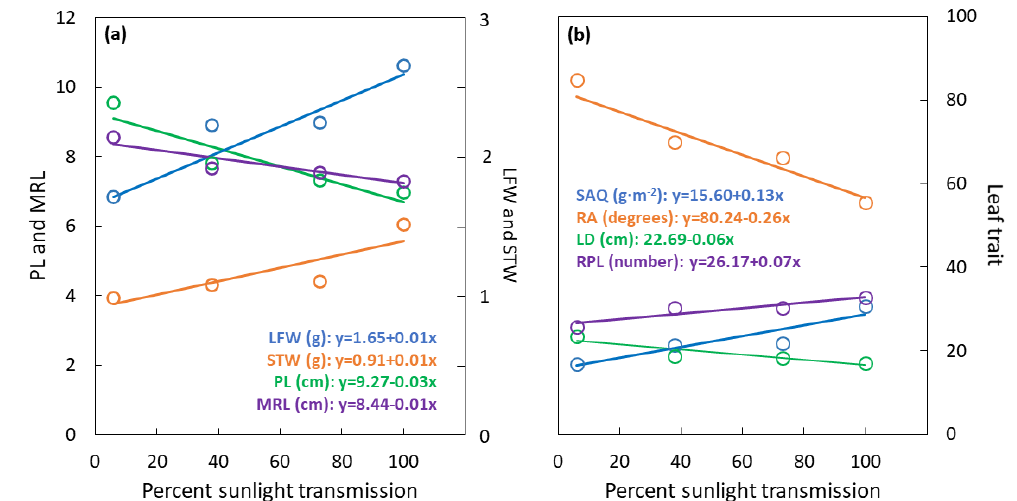
Figure 3. Serianthes nelsonii leaf traits as influenced by percent sunlight transmission during leaf development. ( a ) LFW = dry weight of all leaflets, p < 0.001, r 2 = 0.71; STW = dry weight of petiole, rachis, and all rachillae, p < 0.001, r 2 = 0.86; PL = petiole length, p < 0.001, r 2 = 0.87; MRL = maximum rachilla length, p < 0.001, r 2 = 0.84. ( b ) SAQ = STW / area of all leaflets, p < 0.001, r 2 = 0.85; RA = mean angle of rachilla insertion, p < 0.001, r 2 = 0.91; LD = whole leaf diameter, p < 0.001, r 2 = 0.82; RPL = number of rachilla per leaf, p < 0.001, r 2 = 0.85.